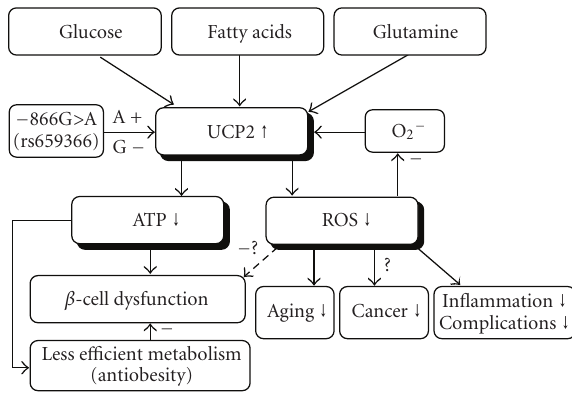
Figure 1: Mechanism by which UCP2 activation may lead to obesity and type diabetes. UCP2 upregulation by nutrients (glucose, lipids, fatty acids, glutamine (protein-rich diet)) increases UCP2 mRNA transcription or translation. UCP2 activity is increased by superoxide radicals. Increased UCP2 amount or activity causes β - cell dysfunction [29] and may contribute to decreased metabolic e ffi ciency by decreasing ATP-generation. UCP2 activation decreases oxidative stress and may therefore decrease aging [30], cancer progression [31], and inflammation [32]. Decreased ROS levels may also protect β -cell [33]. Decreased ATP-generation by UCP2 upregulation may cause less e ffi cient metabolism and protect against obesity, which will decrease demand for insulin secretion by the β